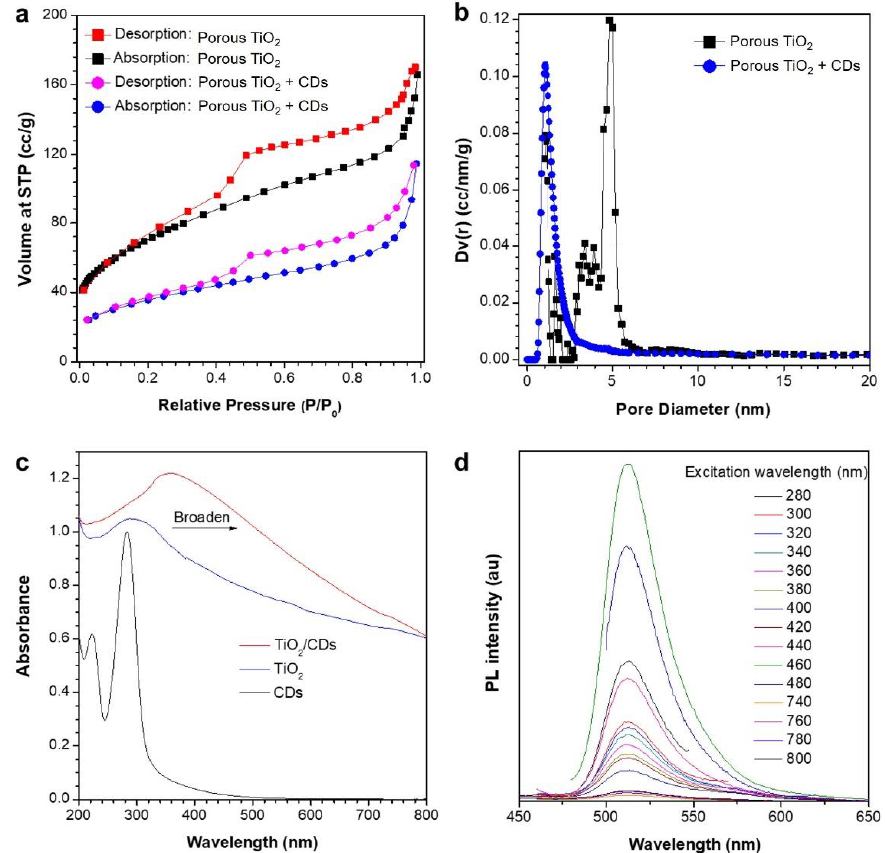
Figure 5. ( a ) Nitrogen adsorption–desorption isotherm curves of porous TiO 2 and porous TiO 2 /CDs particles. ( b ) Pore size distribution curves of the porous TiO 2 and porous TiO 2 /CDs particles. ( c ) UV-Vis of CDs (from D-glucose with ethanol), porous TiO 2 and porous TiO 2 /CDs nanocomposite particles. ( d ) Photoluminescence spectrums of the porous composite TiO 2 /CDs (add up-conversion). The UV-Vis absorption spectra of the pure CDs, the pure porous TiO 2 and the TiO 2 /CDs are shown in Figure 5c,d. Pure CDs exhibited two strong absorption peaks in the UV region, tailing into the visible range until λ = 550 nm. The curves of the porous TiO 2 and TiO 2 /CDs showed strong light absorption at the UV and visible wavelength of 200 – 800 nm. Notably, compared with the pure porous TiO 2 , the TiO 2 /CDs showed a wider peak and higher absorption intensity, indicating a significant enhancement of light ab- sorption. The peak position of the porous TiO 2 was located at ~290 nm, while that of the TiO 2 /CDs shifted to ~365 nm. Similarly, the P25 TiO 2 with the CDs incorporation demon- strated a broader peak, a higher absorption intensity and a longer wavelength of the peak position than the pure P25 TiO 2 , as can be seen in Figure S1. For both our synthesized TiO 2 and the commercial P25 TiO 2 , their light absorbance was extended and enhanced with the import of CDs. The reason for the enhancement of the UV and the visible light absorption can be attributed to two parts: (1) the TiO 2 /CDs performed like a “dyade” structure, where the TiO 2 and the CDs may form a joint electronic system, which gives rise to synergistic properties [6]; (2) the CDs themselves, which can absorb UV light and parts of visible light [10]. The above results indicate that we demonstrated the design of photocatalysts to en- able us to harness the full spectrum of sunlight. The porous TiO 2 , with its high surface area, possessed better absorbance of the UV light and even the visible light than the com- mercial P25. Moreover, the sensitization of the TiO 2 with the CDs could significantly en- hance their UV-Vis light absorption and reduce the extinction in the IR region. The as-